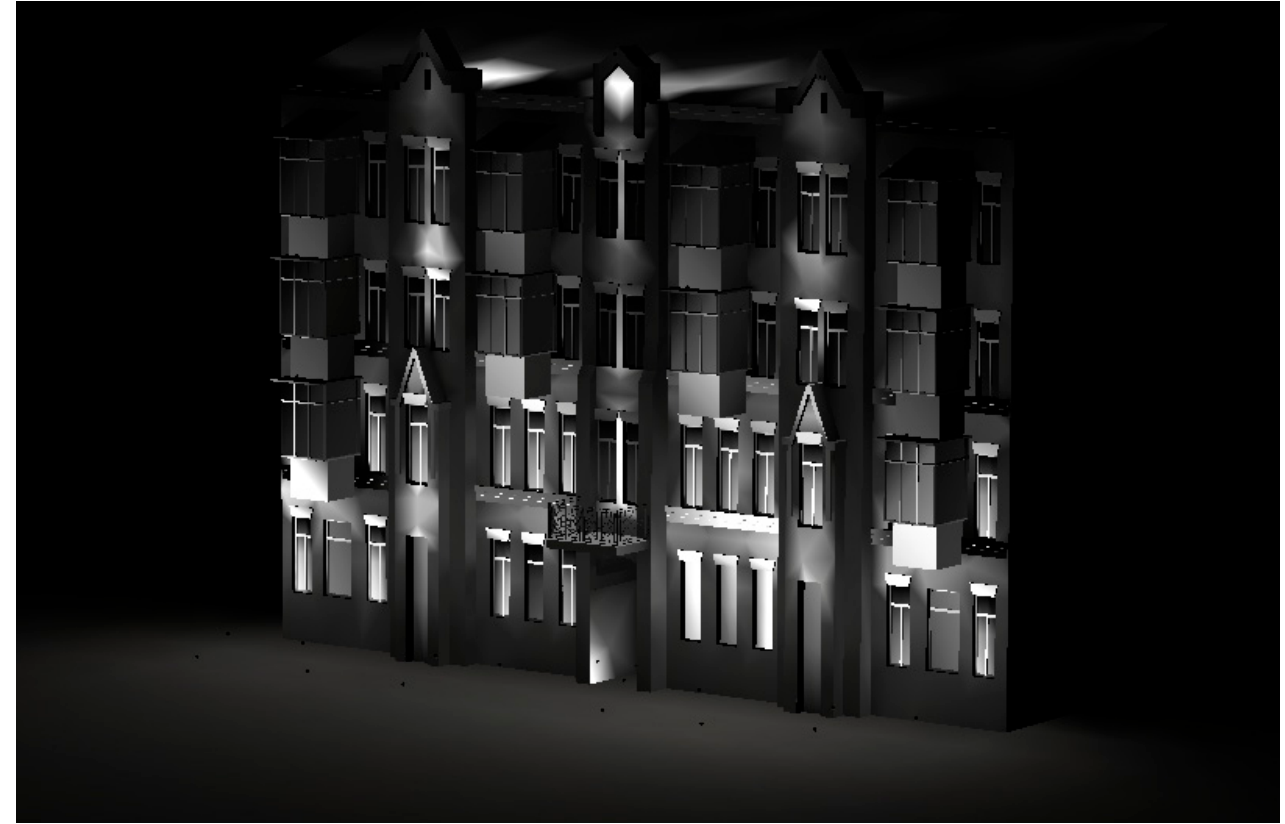
Table 1. This is a tentative list of symbolizing lighting techniques, created by the authors, based on previous works [64]. previous works [64]. Figure 18. A typical façade lighting configuration. Figure 18. A typical façade lighting configuration.